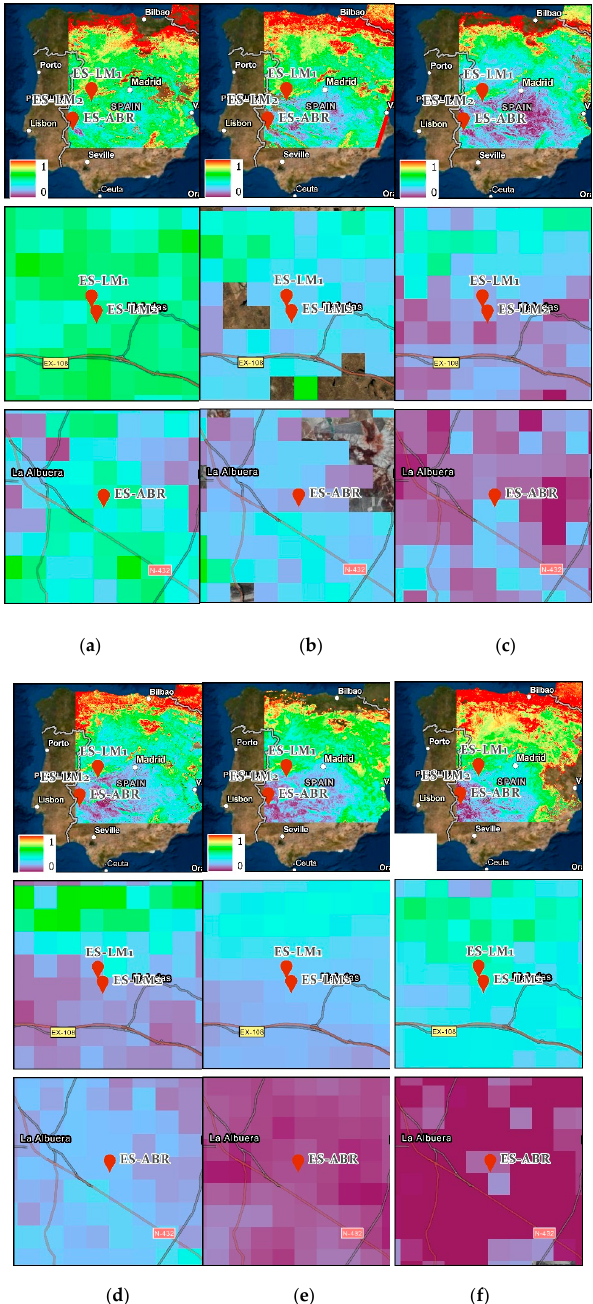
Figure 7. Examples of Mo maps derived from the “simplified triangle” using the Sentinel-3 data. The Mo maps refer to the following acquisition dates: ( a ) 16 May, ( b ) 23 June, ( c ) 25 July, ( d ) 5 August, ( e ) 25 August, and ( f ) 25